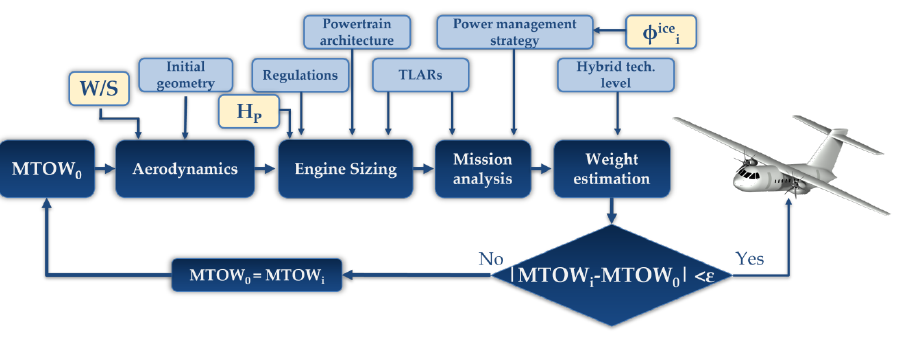
Figure 2. THEA-CODE workflow.